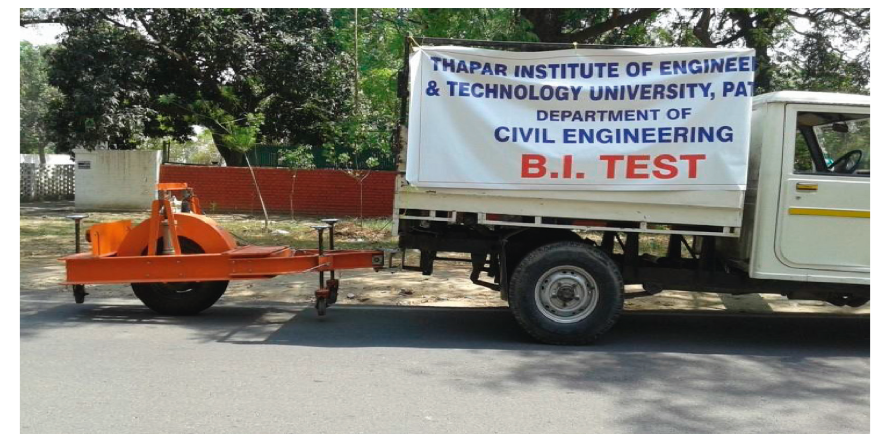
Figure 12: Bump integrator test (roughness test) in progress on the section